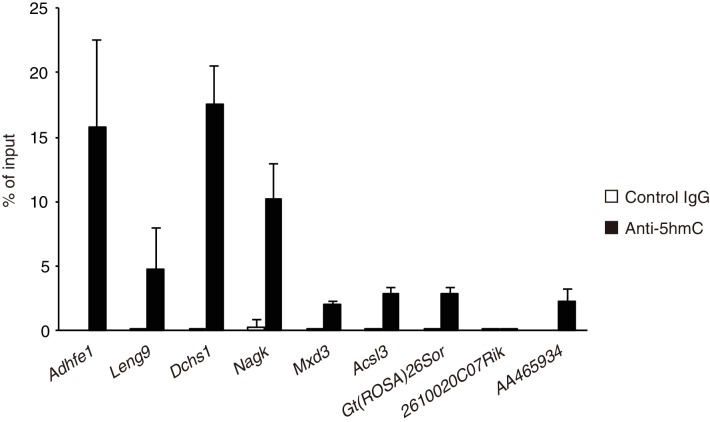
Deposition of 5hmC at Fam60a target gene promoters as revealed by hMeDIP analysis in WT embryos at E9.5.Data are expressed as percentage of input and are means ± s.d. for four independent experiments.